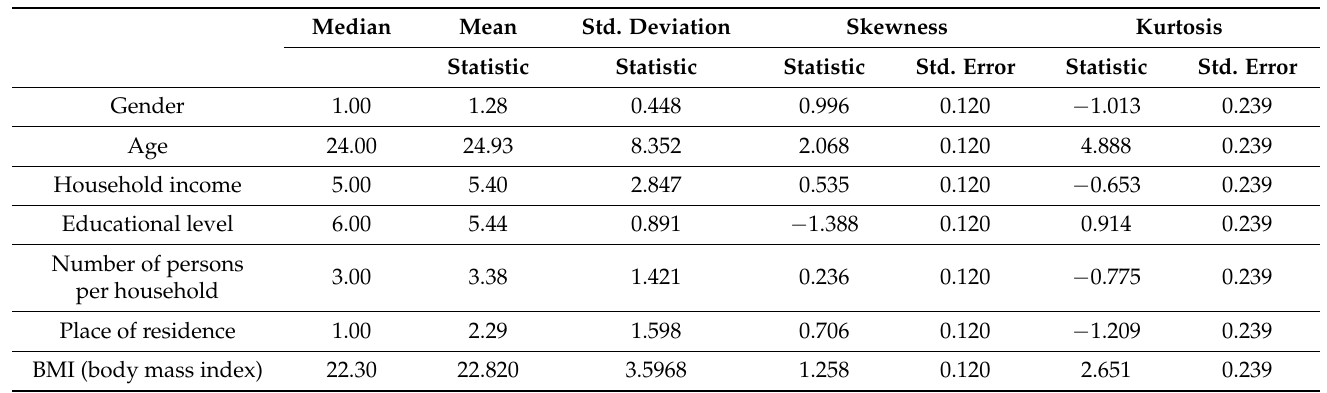
Table 1. Descriptive statistics of the